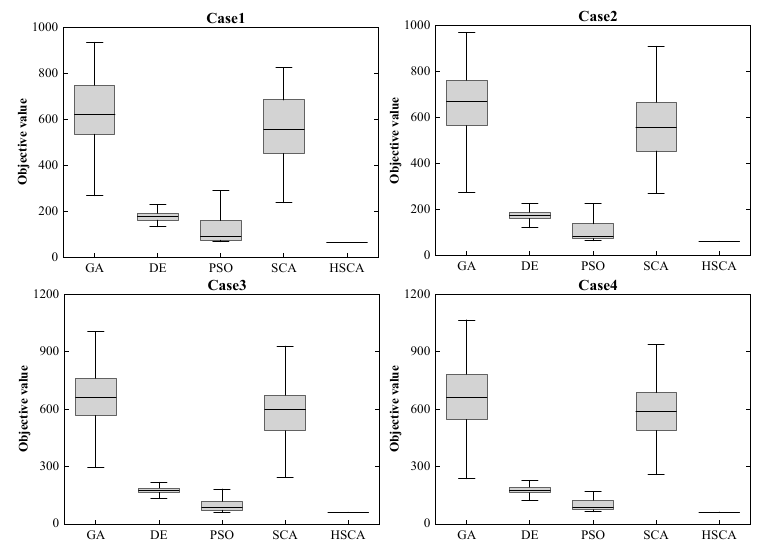
Figure 10. Results of different methods for the mature hydropower system in four cases.